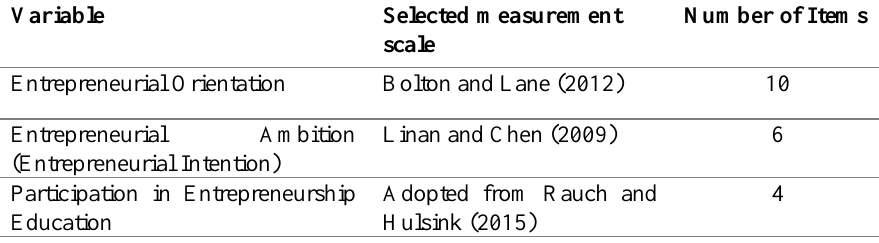
Table 02: Selection of measurement scales for variables